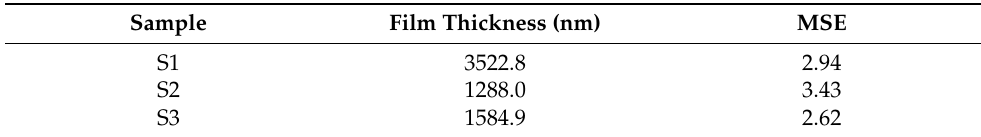
Table 3. Thickness and fit error (mean squared error (MSE)) obtained by modeling of the experimental SE spectra.